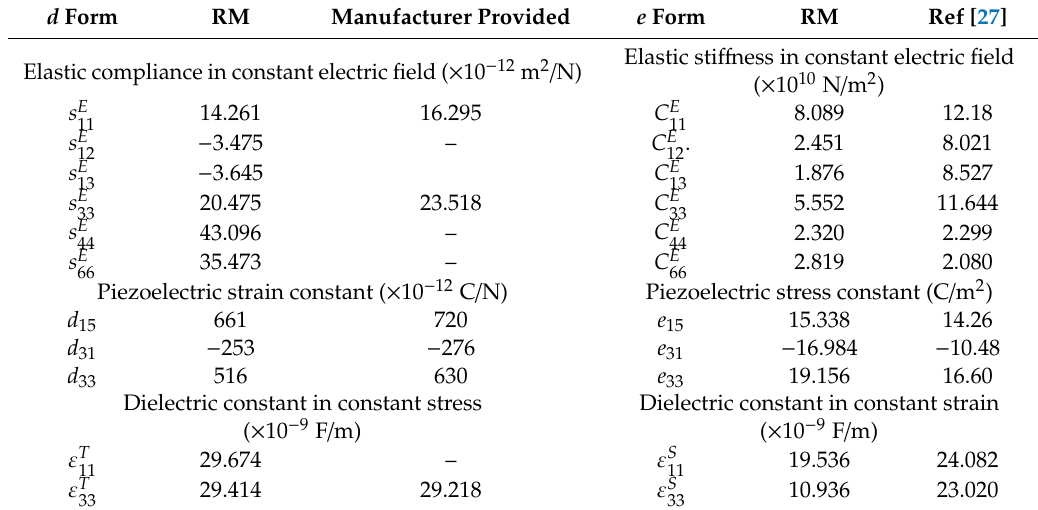
Table 8. Material constant of APC-855 by resonance method, manufacturer, and Ref [27]. d Form RM